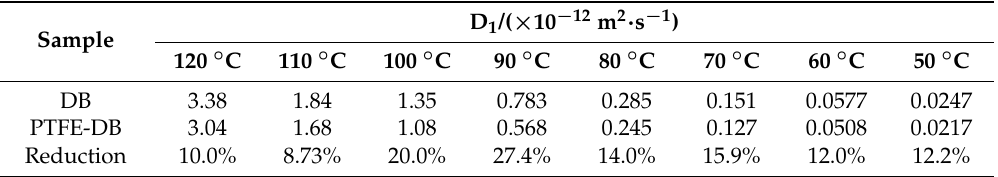
Table 4. Diffusivity of NG calculated from early stage evaporation.